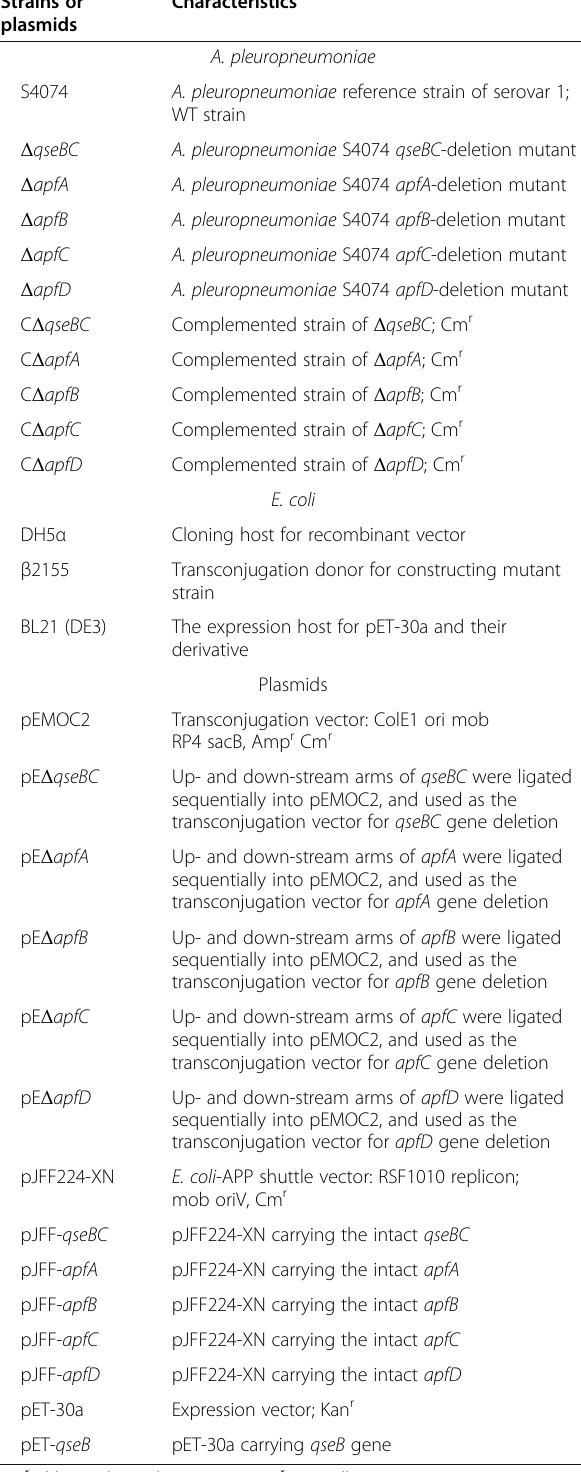
Table 1 Strains, plasmids and protein used in this study Strains or